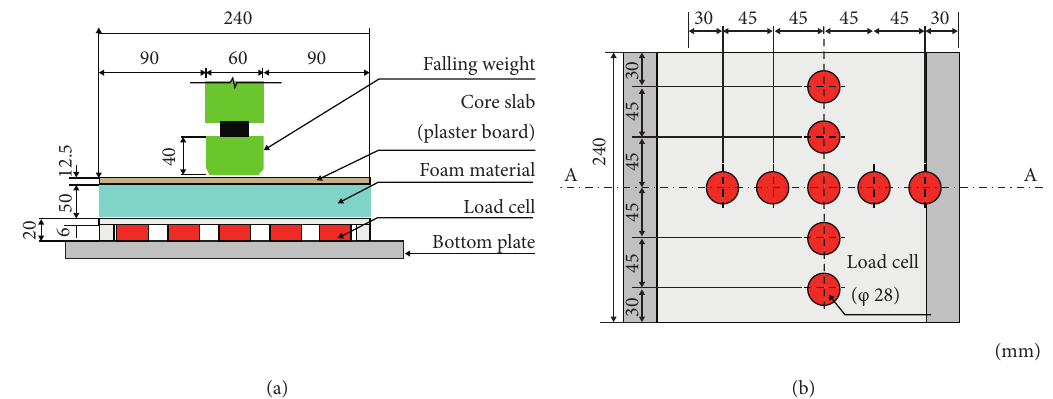
Figure 3: Outline of specimen and transmitted impact stress measurements. (a) A-A section. (b) Plan